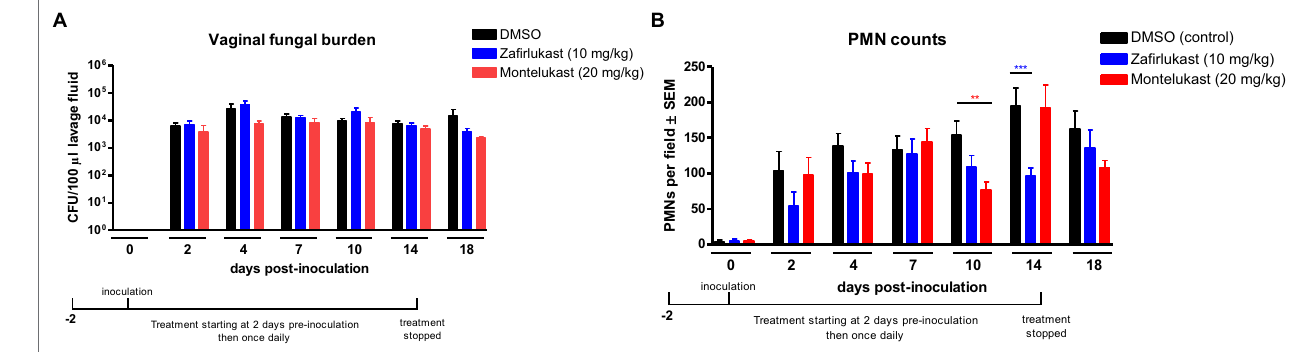
FIGURE 2 | Treatment with cysteinyl leukotrienes receptor antagonists does not reduce PMN migration to the vaginal cavity following inoculation with C. albicans. Estrogenized C3H mice were administered Zafirlukast (10 mg/kg), Montelukast (20 mg/kg) or vehicle alone (10% DMSO) in a volume of 100 μ l by i.p. injection on 2 days prior to inoculation then once daily for 16 days. Mice were intravaginally inoculated with 5 × 10 4 C. albicans 96,113. Vaginal lavage fluid was collected longitudinally over a period of 18 days post-inoculation. (A) Vaginal fungal burden was assessed by quantitative plate counts at the indicated time points. (B) Vaginal cellular infiltrates were stained by the Pap smear technique and examined by light microscopy at x400 magnification. Number of PMNs were quantified in 5 nonadjacent fields per sample and averaged. Data represent cumulative results of 7 independent experiments performed with 5–10 animals/group. Data were analyzed by using the unpaired Student’s t test comparing the drug-treated groups with vehicle control group at specific time points. ** p < 0.01; *** p < 0.001. CFU, colony-forming unit; PMN, polymorphonuclear